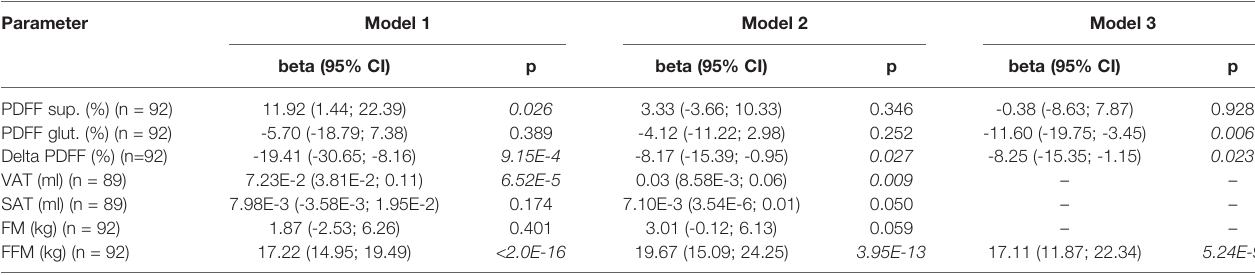
TABLE 2 | Association between parameters of adipose tissue and RMR.